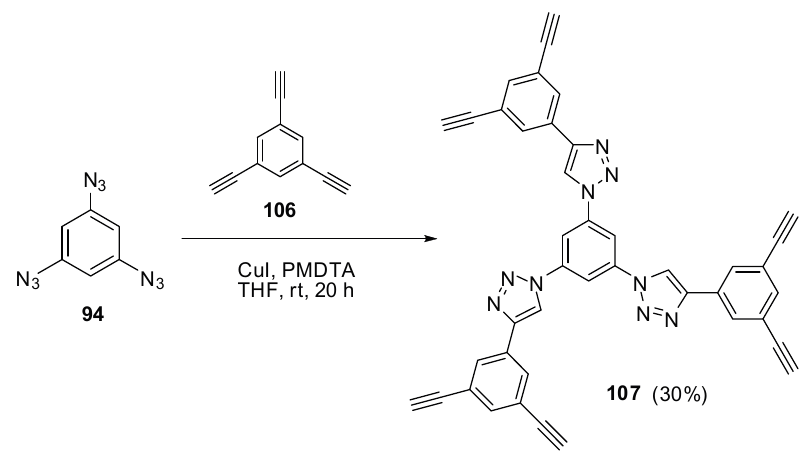
Scheme 27. С lick-reaction of triazide 94 with tris -acetylene 106